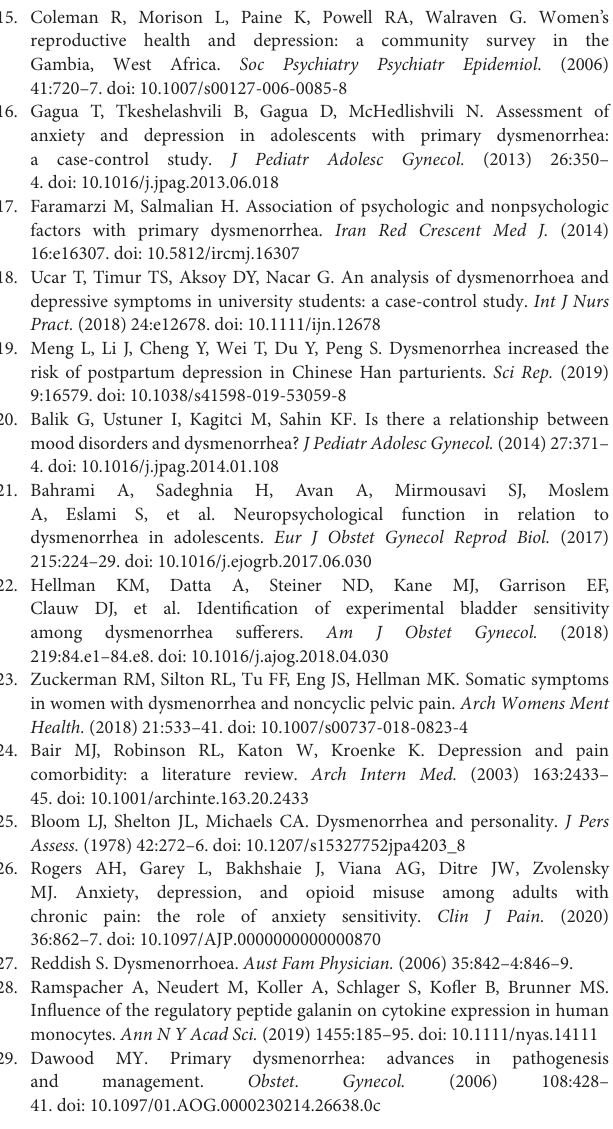
Supplementary Figure 2 | Sensitivity analysis after each study was excluded by turns. Supplementary Table 1 | The methodological quality of the cross-sectional studies. Supplementary Table 2 | Newcastle-Ottawa Scale (NOS) assessment of the quality of the case-control studies. Supplementary Table 3 | Sensitivity analysis after each study was excluded by